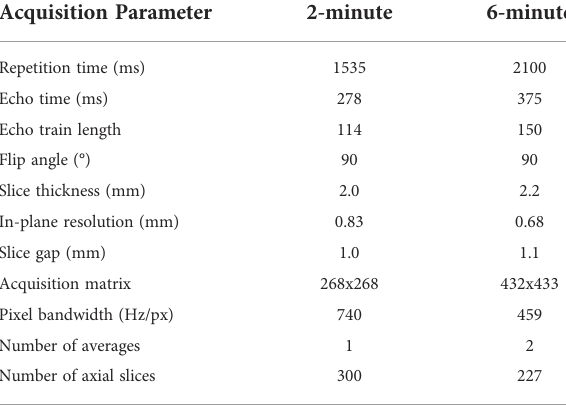
TABLE 1 MRI sequence acquisition parameters for the 2-minute and 6-minute MRI scans used in this study.